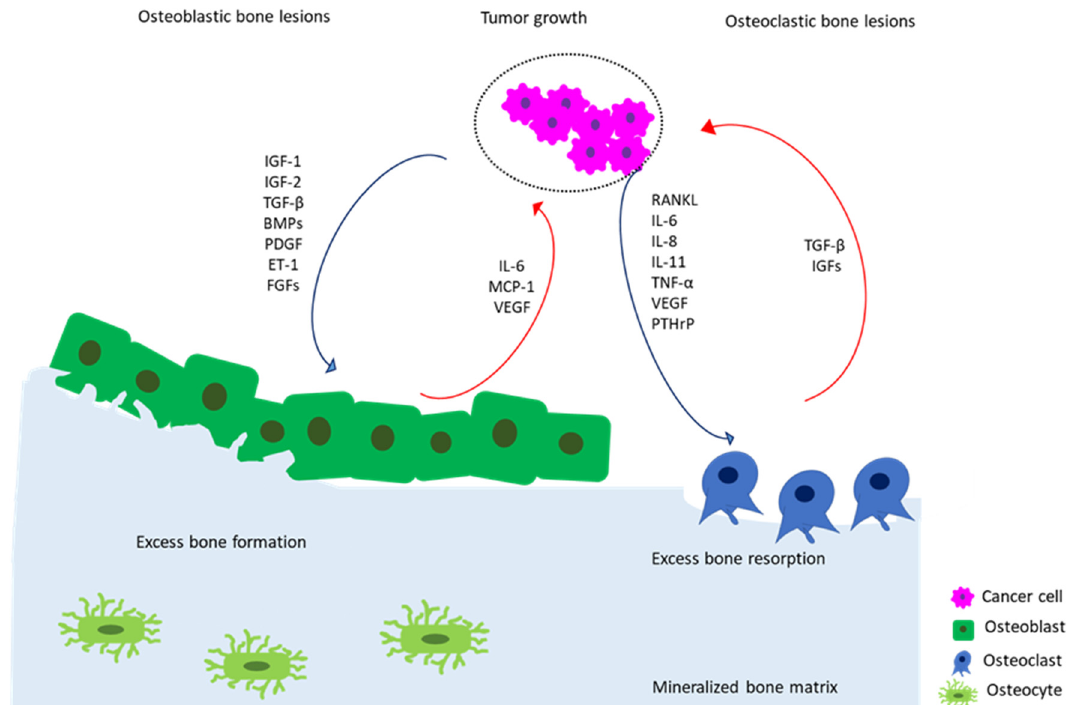
Figure 1. Schematic depiction of vicious cycle of bone metastasis involving the complex mutual interactions between tumor cells and bone cells in osteoblastic and osteoclastic bone lesions. Tumor cells secrete pro-osteoblastic (i.e., IGF-1 and -2, TGF- β , BMPs, PDGF, ET-1, and FGFs) or pro-osteoclastic (i.e., RANKL, IL-6, IL-8, IL-11, TNF- α , VEGF, and PTHrP) mediators (blue arrows) that induce bone formation or bone resorption, respectively. In turn, in osteoblastic lesions, osteoblasts produce pro-tumor growth factors (i.e., IL-6, MCP-1, and VEGF) that further stimulate the growth of cancer cells (red arrows). In osteolytic lesions, osteoclast-mediated bone resorption induced by cancer cells triggers the release of pro-tumor growth factors (i.e., IGFs and TGF- β ) from the bone matrix, thus fueling the vicious cycle of cancer growth (red arrows).